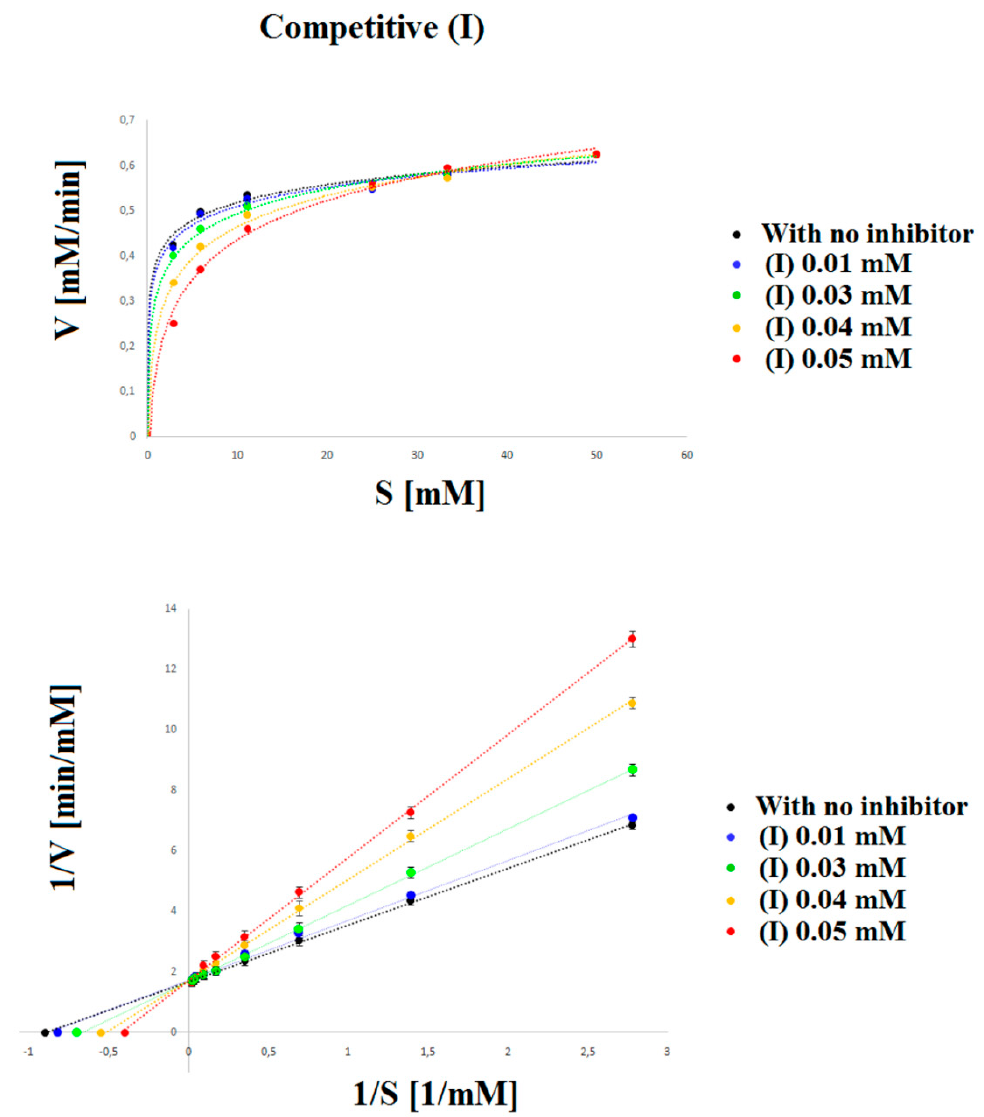
Figure 3. Michaelis–Menten and Lineweaver–Burk plots for the reaction of acid phosphatase with p-nitrophenyl phosphate inhibited by: ( • ) 0.00 mM, ( • ) 0.01 mM, ( • ) 0.03 mM, ( • ) 0.04 mM and ( • ) 0.05 mM (I). The figure shows three straight lines with different intersection points with the 1/S axis and a common intersection with the 1/V axis. Such a system indicates the competitive type of inhibition. The larger the slope of the curve, the stronger the competitive inhibitor of the tested compound is.